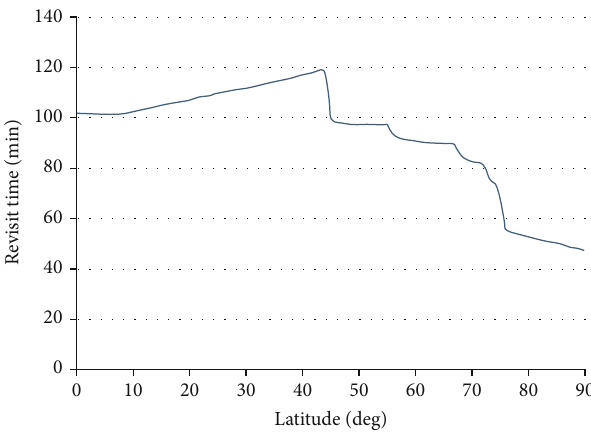
Figure 17: Results for 6 COF satellites at 650km.